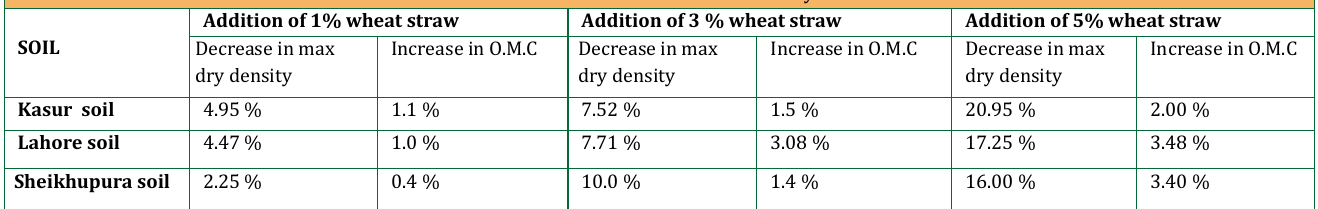
Table 1: Effect of wheat straw on M.C and dry densities